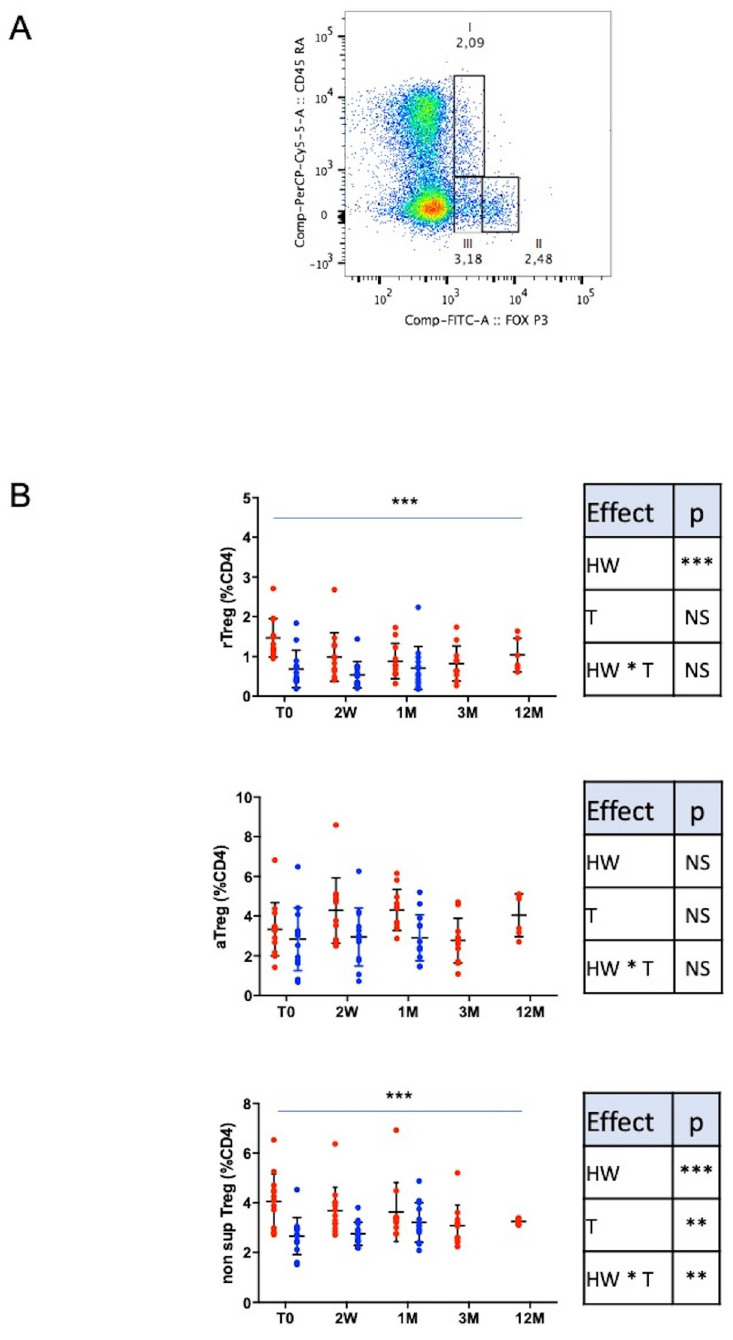
Fig 2. Treg sub-populations. A: Example of gating strategy to define the 3 subpopulations of Treg. CD45RA+FoxP3 lo (rTreg), CD45RA-FoxP3 lo (non-suppressive T cells) and CD45RA-FoxP3 hi (aTreg). B: Longitudinal results of rTreg, a Treg and non-suppressive Treg in the HW+ et HW- groups. Results are expressed as mean +/- SD. HW+: population infected with hookworm, HW-: control group, 2W: 2 weeks, 1M: 1 month, 3M: 3 months and 12M: 12 months after treatment. The HW+ group is represented with red dots and the HW- group with blue dots. To compare the HW+ and HW- groups and their evolution, a maximum likelihood analysis has been used to test a group (HW), a time (T) and a group � time (HW � T) interaction effects (with data at T0, 2W and 1M). Statistical results are summarized in correspondent tables for each parameter. To compare longitudinal data from the HW+ group (T0, 2W, 1M, 3M and 12M), a time and a time 2 effects were tested. The time effect is depicted on the figures and the time 2 effect is given in the results section ( � p < 0.05, �� p < 0.01, ��� p < 0.001).